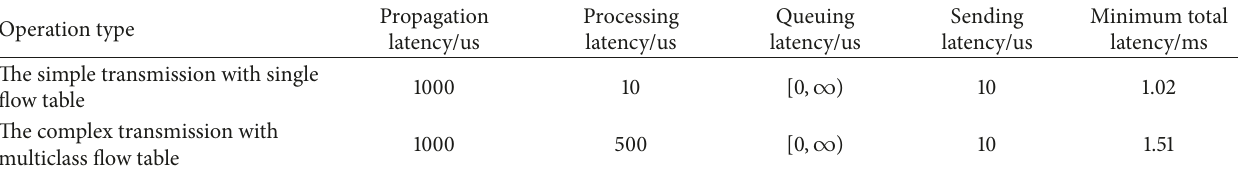
Table 2: Network latency in SDN-enabled communication network